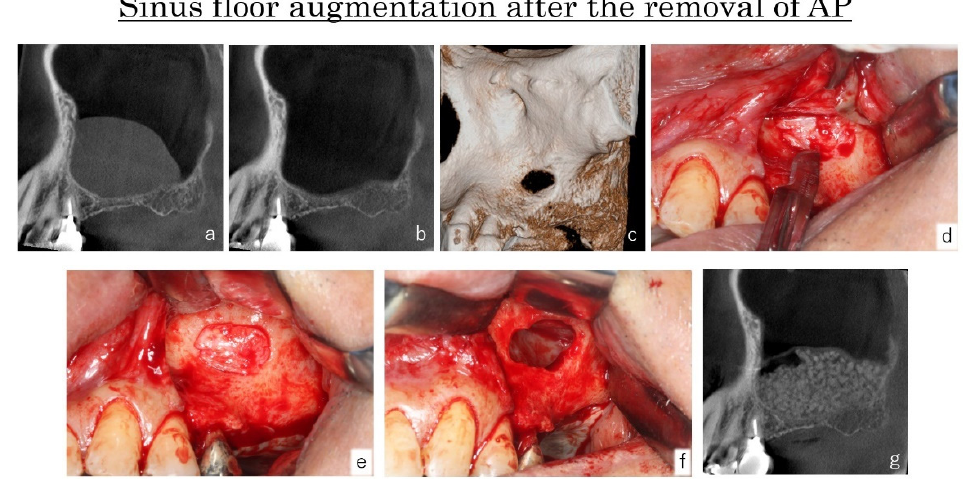
Figure 13. Case: 48 years old male. Three months after the removal of AP, the swelling of the sinus membrane had disappeared ( a , b ). As the bone defect at the antrostomy was still present, the dissec- tion of the scar tissues between the sinus membrane and oral mucosa was performed during the elevation of the muco-periosteal flap ( c – e ). The sinus floor augmentation was completed without perforations of the sinus membrane ( f ) and bone materials were fill at the augmented area ( g ). In 8 sinuses (18.2%) of 44, the ruptures of sinus membrane had occurred due to the complex septa. The collagen membranes (Terudermis, Olympus Terumo Biomaterials, Tokyo, Japan) were putted on the surface of the periosteum layer underneath sinus